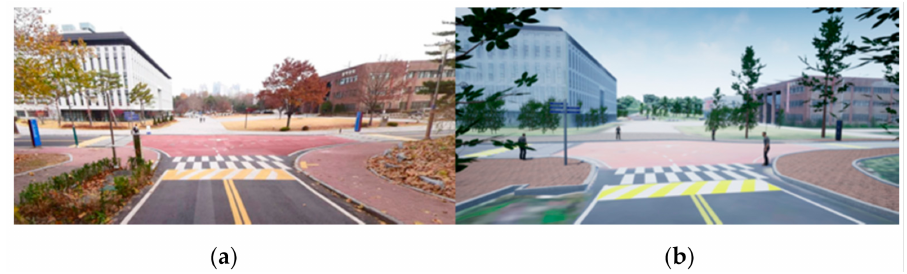
Figure 6. Image similarity comparison between the real and virtual scenes. ( a ) Real scene and ( b ) virtual scene.